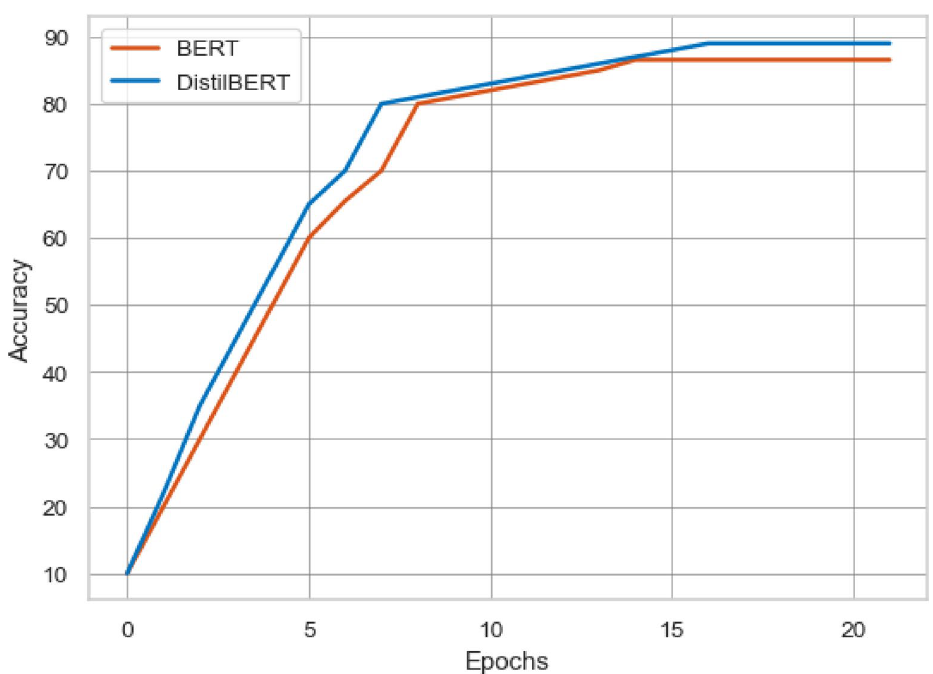
Figure 7. Accuracy comparison of transformer-based models using top 10